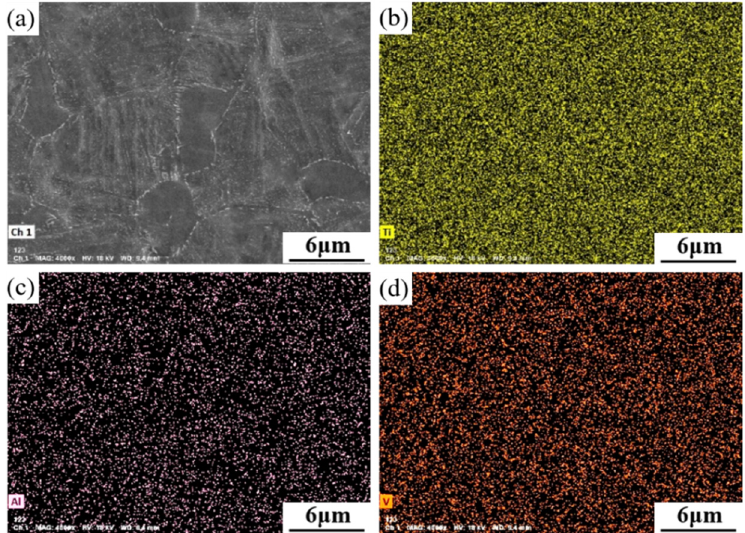
Figure 6. EDS of the sheet aging for 2 h: ( a ) Scanning surface ( b ) Ti ( c ) Al ( d ) V.